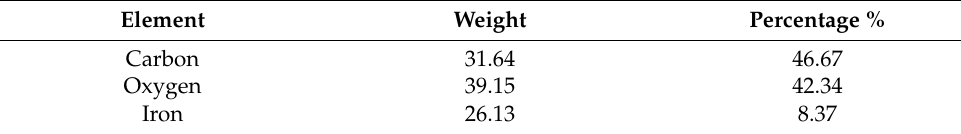
Figure 4. Representation of reaction between cellulose and iron chloride. Table 3. Physicochemical characterization of the ECFe sample. the weight in the sample was iron.